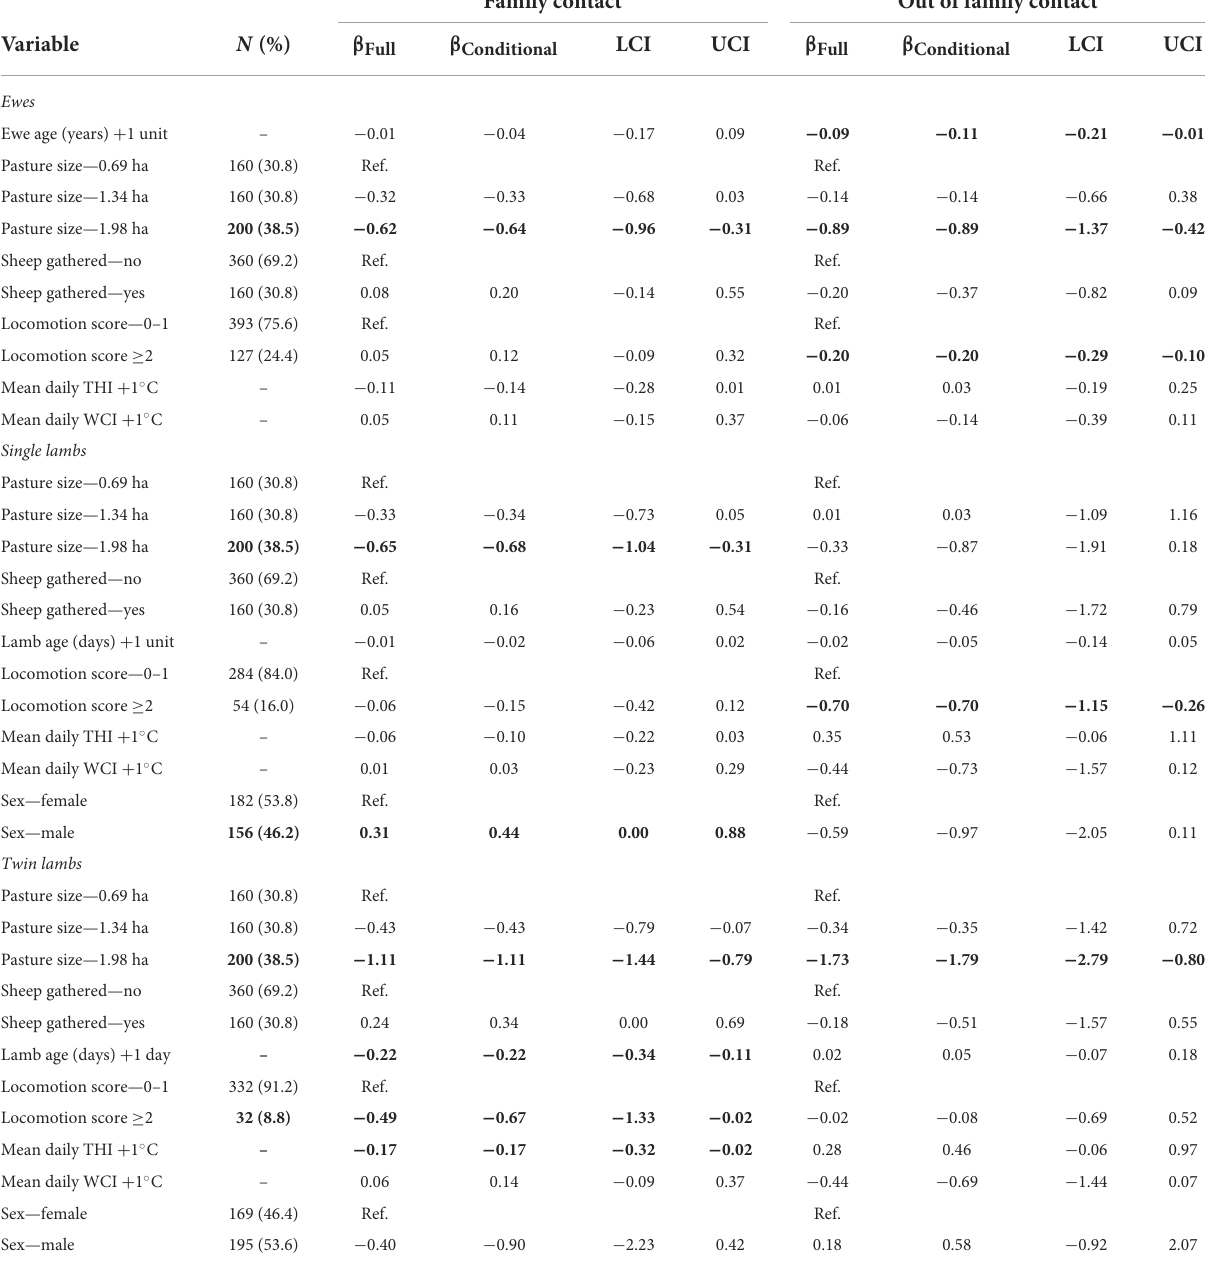
TABLE 6 Linear mixed effects models for factors associated with daily time ewes and lambs spent with their family and other sheep. Family contact Out of family contact Variable